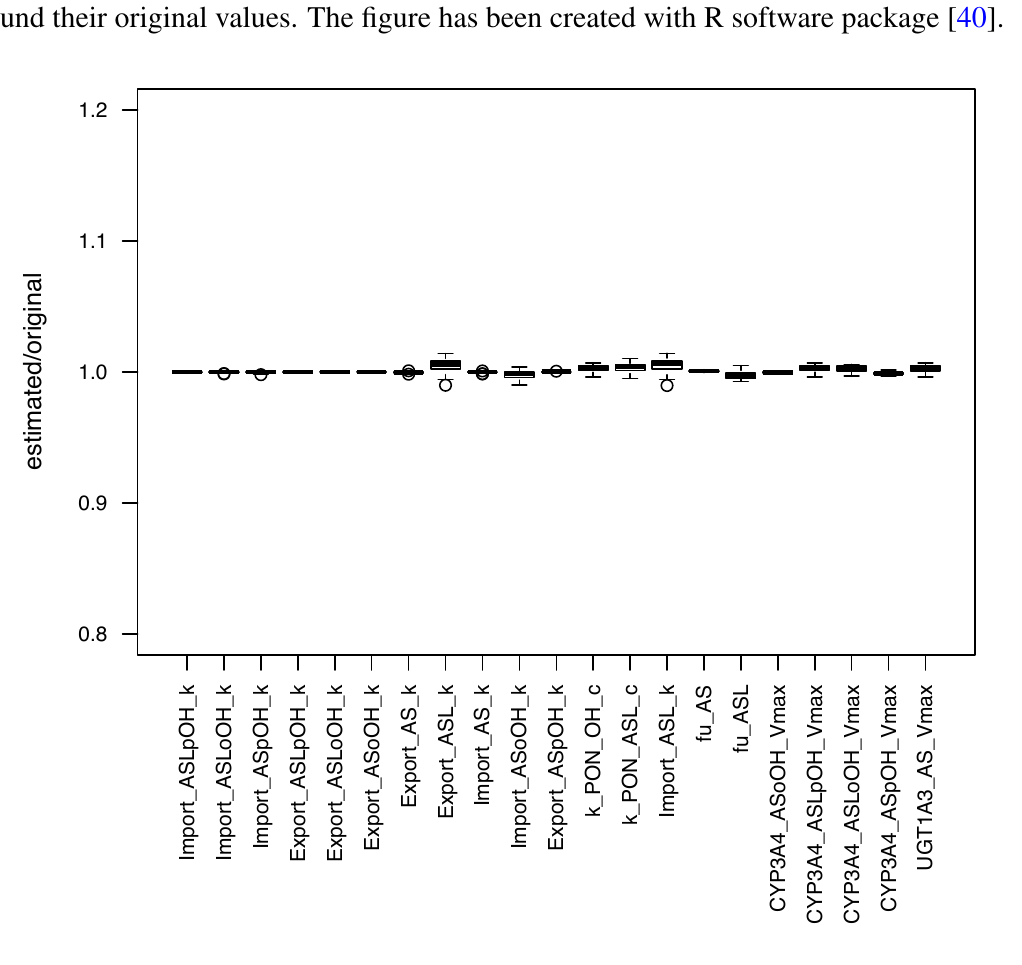
Figure 2. Distribution of parameters estimated with SBMLsimulator. One hundred parameter estimations with SBMLsimulator for the model by Bucher et al. [28] were run on a computer cluster. The distribution of the 50 estimations with the best fitness values is shown here. For each parameter the estimated values were divided by the original parameter value prior to plotting. It is obvious from the plot that all parameters were estimated closely around their original values. The figure has been created with R software package